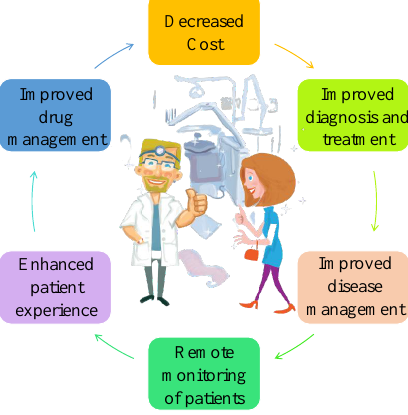
Figure 5. Benefits of IoMT